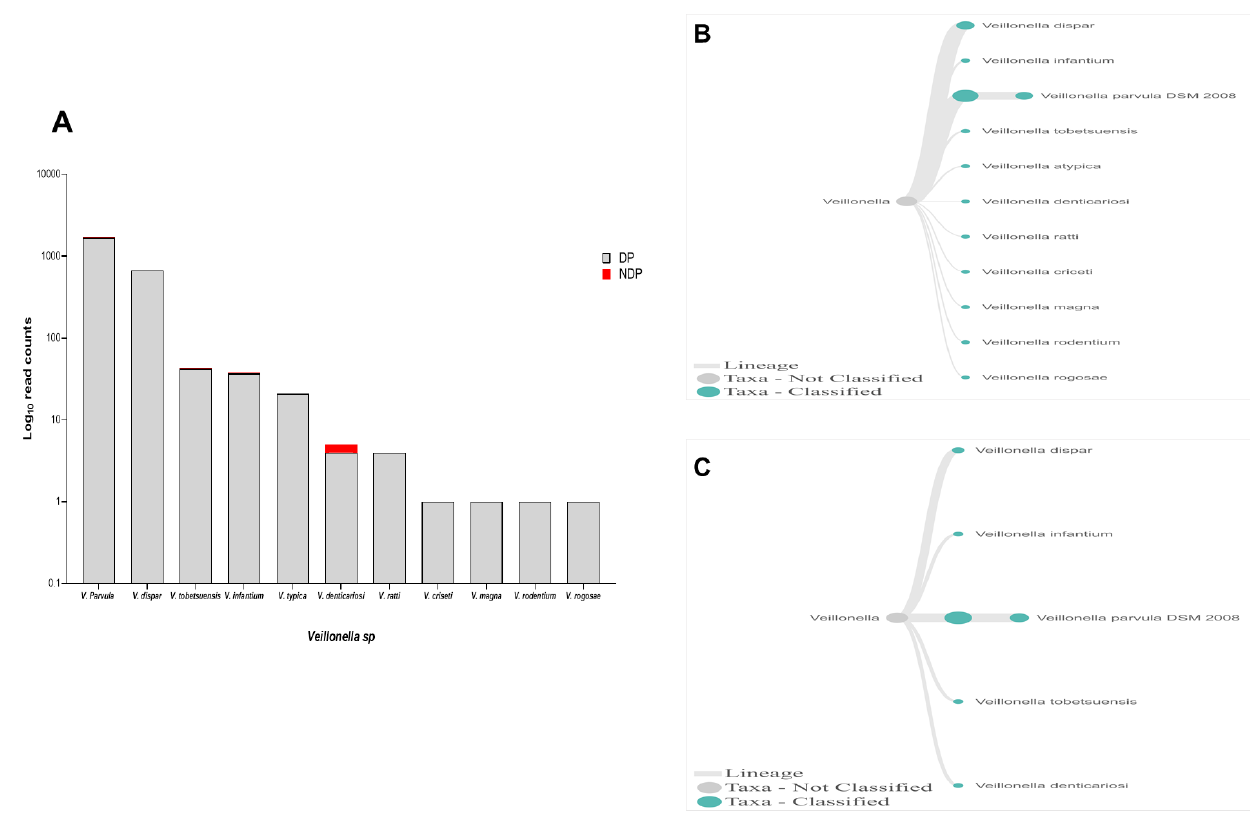
Figure 7. Veillonella sp. in pooled subgingival microbiota samples obtained from diabetic (DP) and non-diabetic (NDP) patients. ( A ) Abundance of Veillonella sp .; ( B and C ) dendrograms showing the variability of Veillonella sp . in DP ( B ) and NDP ( C ) groups.